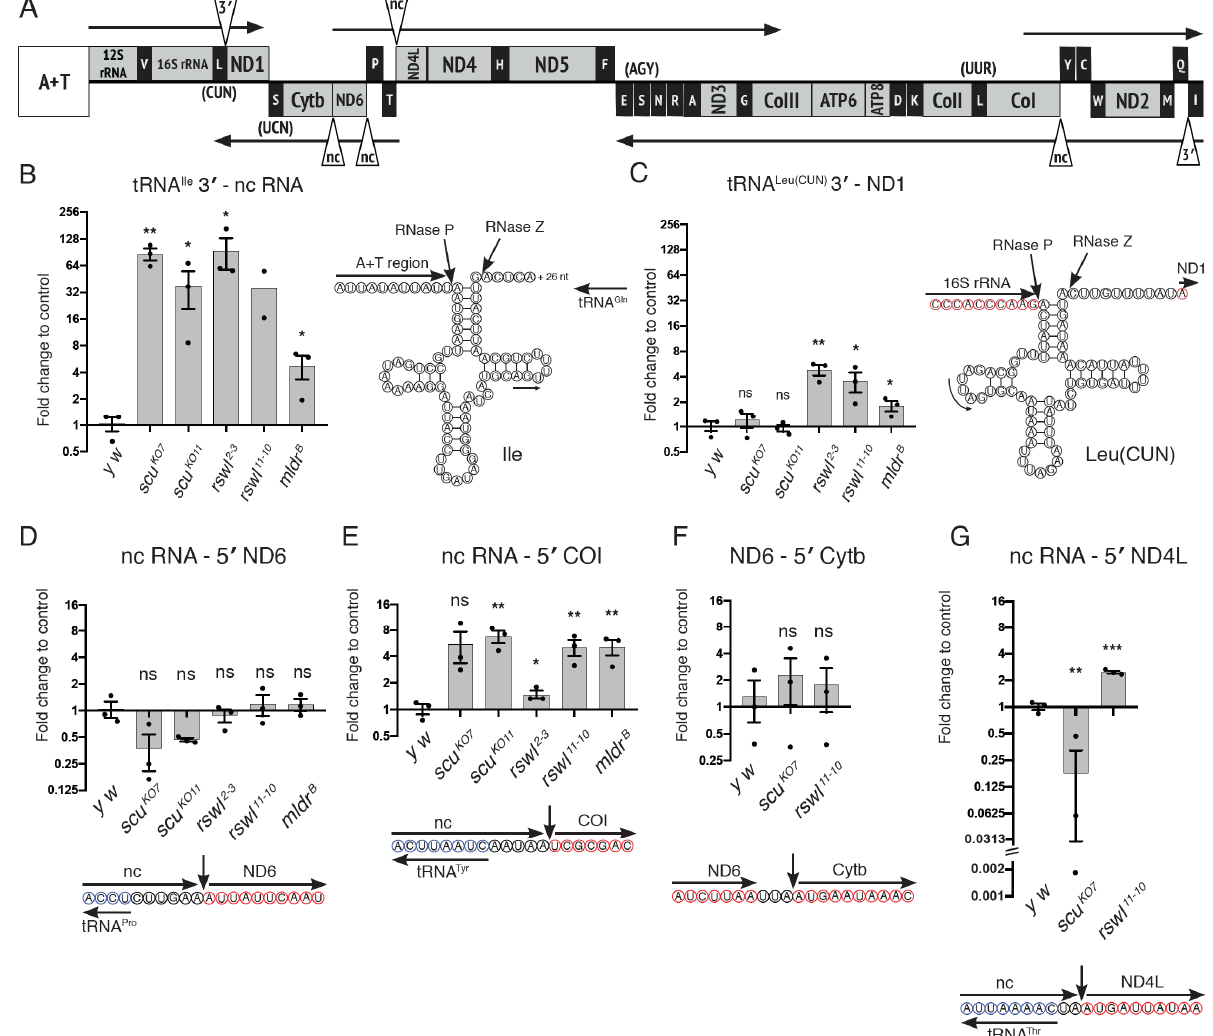
Figure 4. mt:tRNA 3 ′ -end and non-canonical processing are differentially affected by mtRNase P. ( A ) Linear schematic of Drosophila circular mtDNA with triangles indicating the mt:tRNA 3 ′ -end junctions and non-canonical junctions assayed. A+T indicates the adenine and thymine-rich non-coding region that controls replication. ( B , C ) Graphs represent the log 2 fold change in qPCR levels in scu , rswl , and mldr mutant larvae for 3 ′ -end junctions between tRNA Ile 3 ′ : non-coding (nc) RNA ( B ); tRNA Leu(CUN) 3 ′ : ND1 ( C ); ncRNA: 5 ′ ND6 ( D ); ncRNA: 5 ′ COI ( E ); ND6: 5 ′ Cytb ( F ); ncRNA: 5 ′ ND4L ( G ). The corresponding predicted cloverleaf structure of mt:tRNA ( B , C ) or nucleotide context of the 5 ′ -end cleavage site ( D – G ). The internal mt:tRNA forward primer is indicated with an arrow ( B , C ). Red circled nucleotides represent 5 ′ -> 3 ′ mtRNA, and blue represent the mt:tRNA encoded on the opposite strand. Bars on the graphs represent averaged 2^ddCt, and the y-axis is log 2 . Further explanation can be found in the materials and methods. The statistical significance was calculated relative to control ( y w ). Error bars: S.E.M. calculated using GraphPad PRISM using an unpaired t -test, one-tailed. * p < 0.05; ** p < 0.01; *** p < 0.001; ns: not significant.